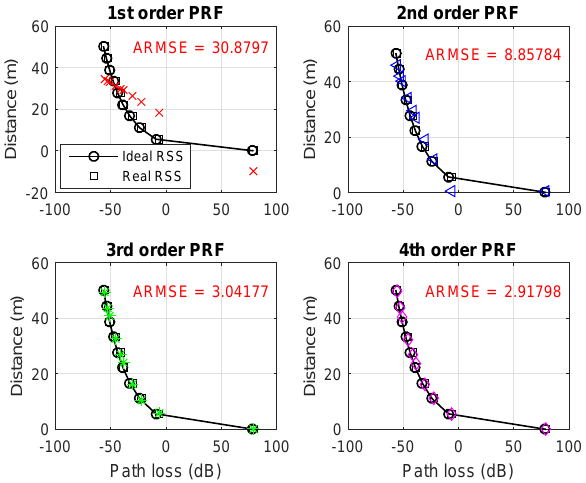
Figure 2. Fitting polynomials for different